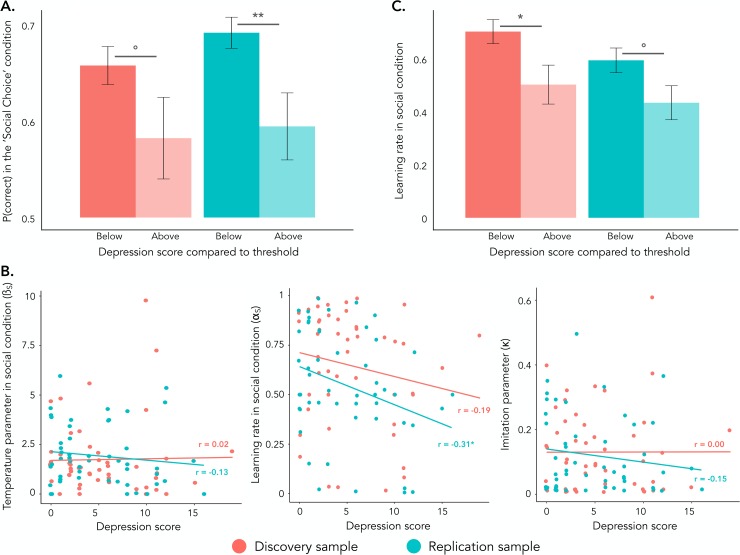
Classification and computational results (A) Model-free classification. The correct choice rate difference between the ‘Private’ and the ‘Social-Choice’ conditions was significantly different between participants with ‘Absent’ and ‘Present’ depressive symptoms. (B) Effect of depression scores on the learning rate in the social context. Higher depression scores were associated with lowered learning rates in the social contexts but not with a significant effect on the two other parameters fitted on the ‘Social-Choice’ condition (C) Model-based classification. The difference between the learning rate of the ‘Private’ and the social information contexts was significantly different between participants with ‘Absent’ and ‘Present’ symptoms of depression. Present symptoms of depression correspond to scores ≥ 8 on the HAD depression subscale, respectively. Error bars represents standard errors to the mean. ‘r’ = Pearson’s correlation coefficient., °p<0.10, *p<0.05, Student’s t-test and Pearson’s correlation.